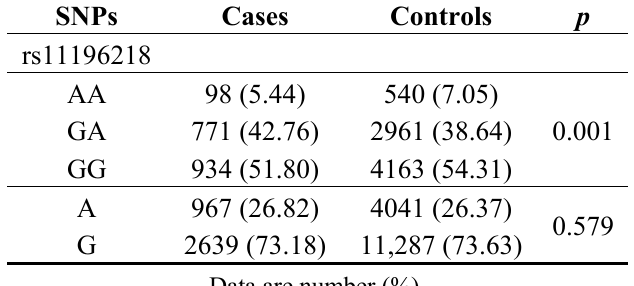
Table 5. Genotypic and allelic distributions of rs11196218 in TCF7L2 gene among Han Chinese.